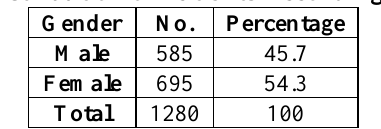
Table 1: Distribution of Patients According to Gender